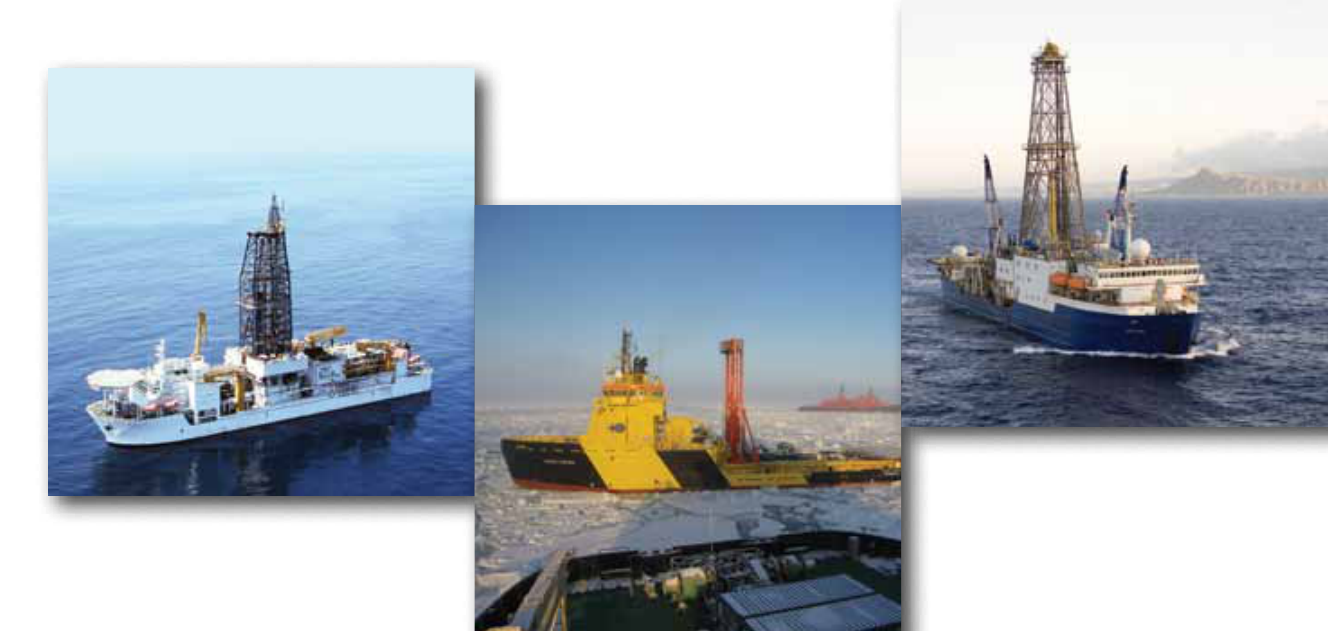
(right) The riserless drilling plat- form d/v JOIDES Resolution. courtesy of